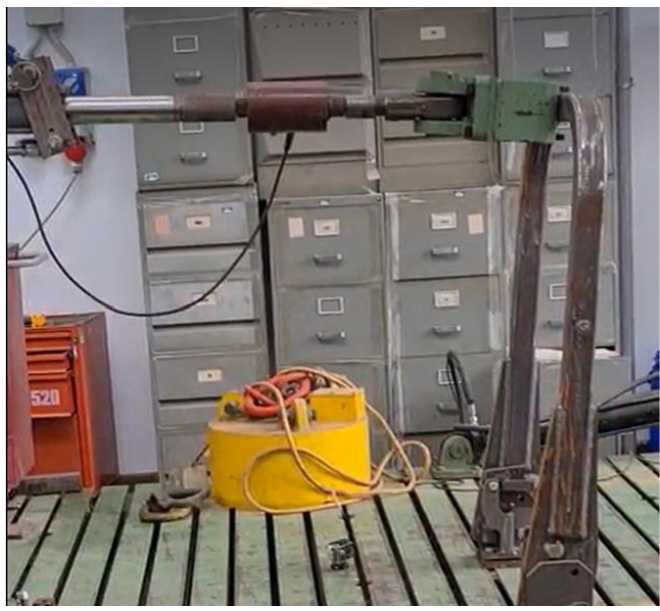
Figure 14. Application of a longitudinal force to test the behavior of the ALD.